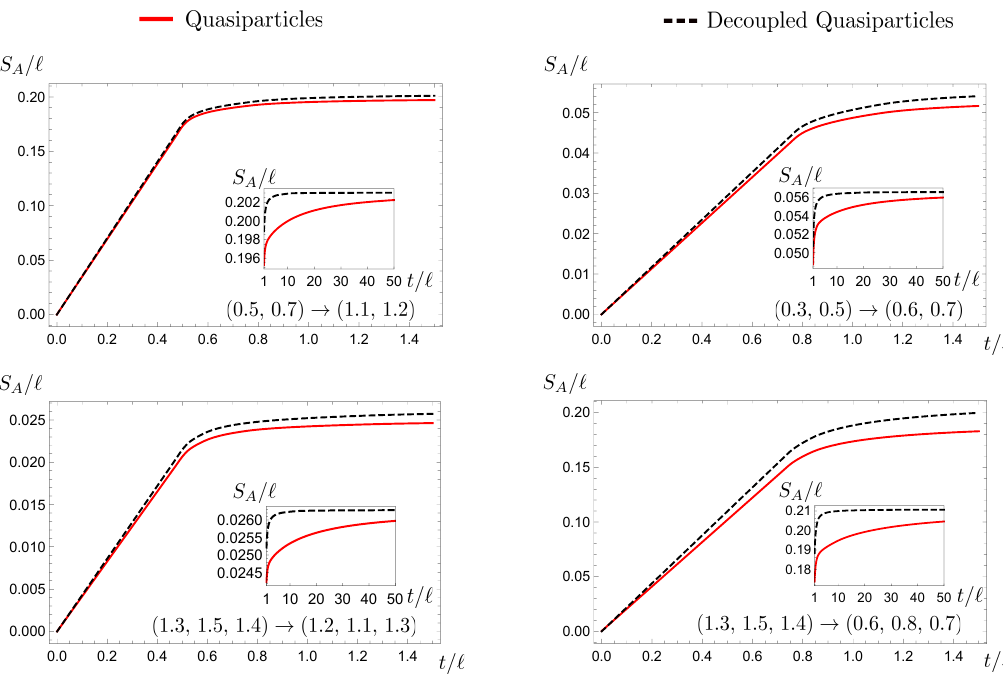
} n → { h } n i i i = 1 i = 1